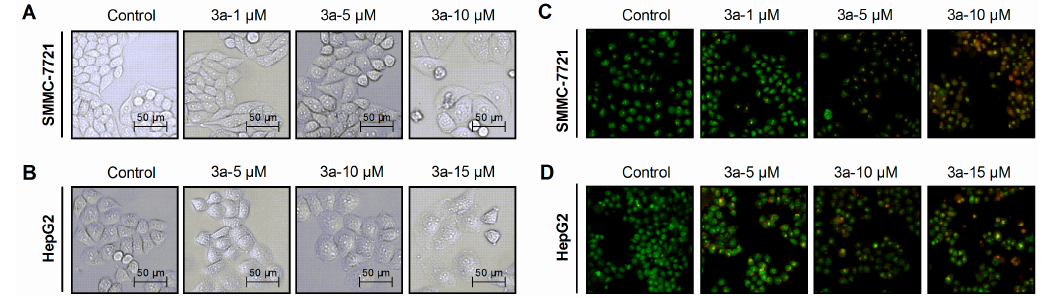
Figure 3. The morphology of SMMC-7721 ( A ); and HepG2 cells ( B ) treated with compound 3a of various concentrations for 48 h. Cells were photographed under an inverted biological microscope (20 × ); Cell membrane integrity and nuclear structure of SMMC-7721 cells ( C ); and HepG2 cells ( D ) treated with compound 3a of various concentrations for 24 h by AO/EB staining using HCS (20 × ). The experiments were repeated three times and representative images are shown.